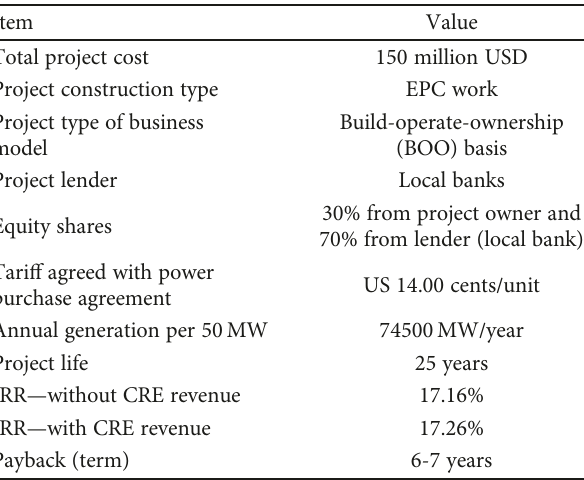
Table 11: The fi nancial fi